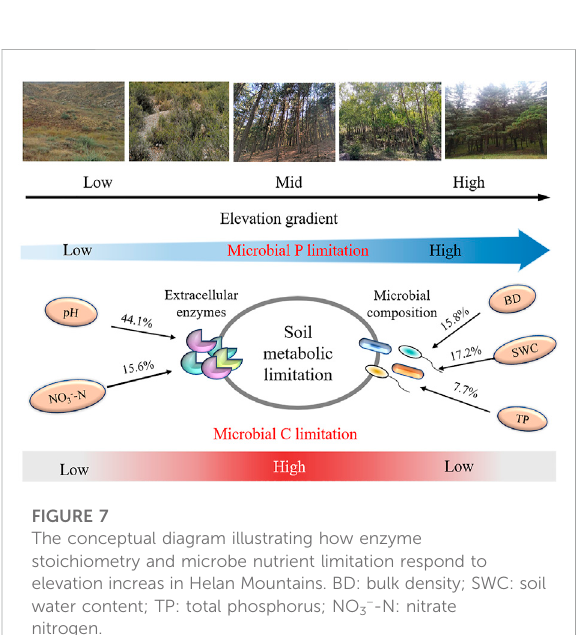
FIGURE 7 The conceptual diagram illustrating how enzyme stoichiometry and microbe nutrient limitation respond to elevation increas in Helan Mountains. BD: bulk density; SWC: soil water content; TP: total phosphorus; NO 3 − -N: nitrate